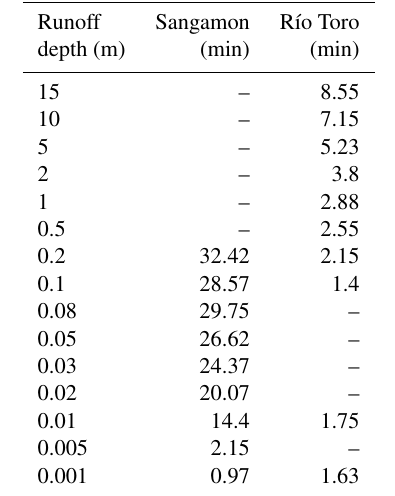
Table 2. Runtimes for mass-conserving depression filling using FlowFill. Runtimes increase with the depth of applied runoff and on flatter landscapes (Table 1).